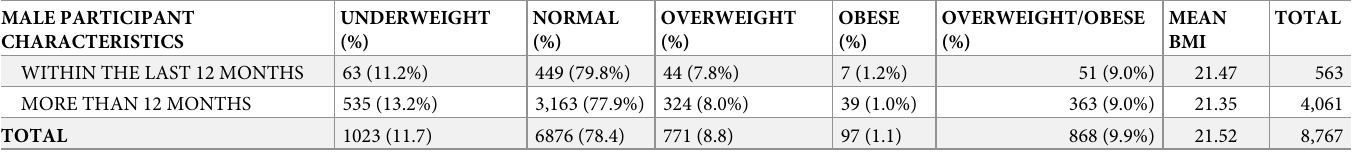
Table 4. Prevalence risk ratio of underweight, overweight, and obesity by participant sex. BMI Category Count (%) Unadjusted PRR (95% CI) Adjusted PRR (95% CI) P-value Underweight Females (Ref.) -- Overweight Females (Ref.) 2,216 (23.8) -- Obesity Females (Ref.) 1,026 (11.0) PRR = prevalence risk ratio. CI = Confidence Interval. Ref. = reference group. Risk of overweight, obesity, or underweight for males and females. Adjusted for age group, community type, socioeconomic status, occupation, marital status, religion, smoking, current alcohol use, and/or last alcohol use. See S1 File for full analysis models, including inclusion of interaction